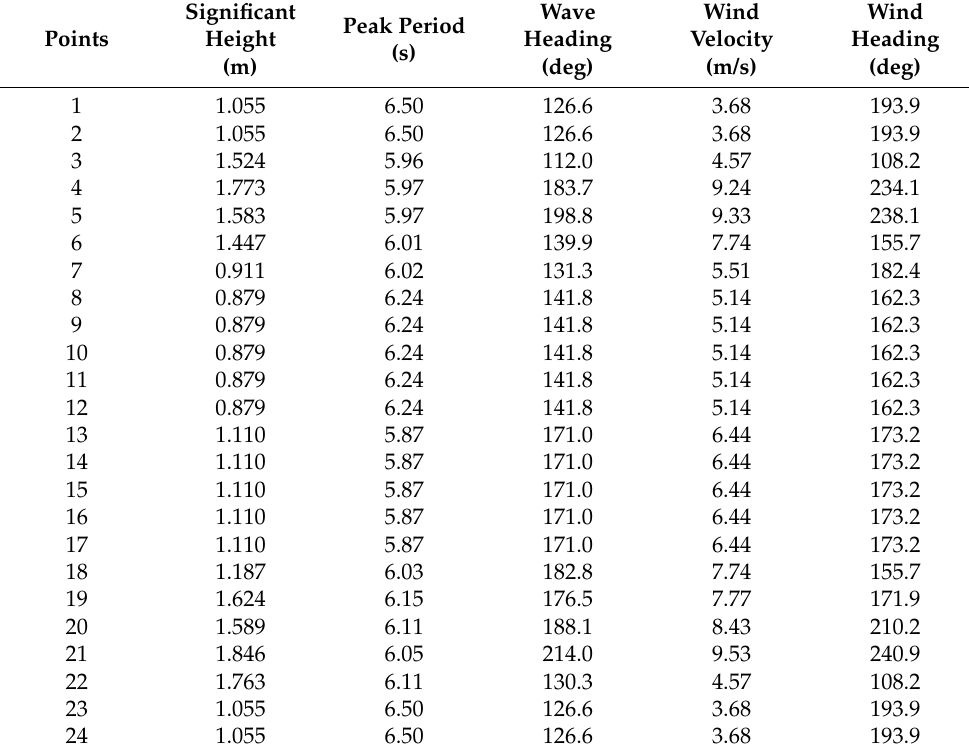
Table A2. Sea state per route point in December to February